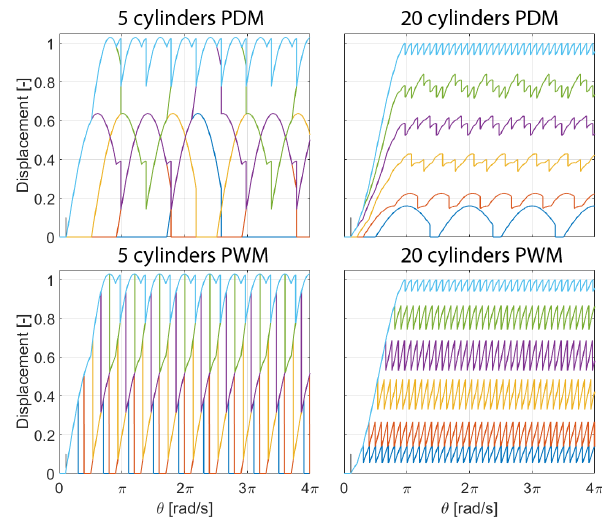
Figure 11: Step response for various displacements using delta-sigma modulation and pulse- density